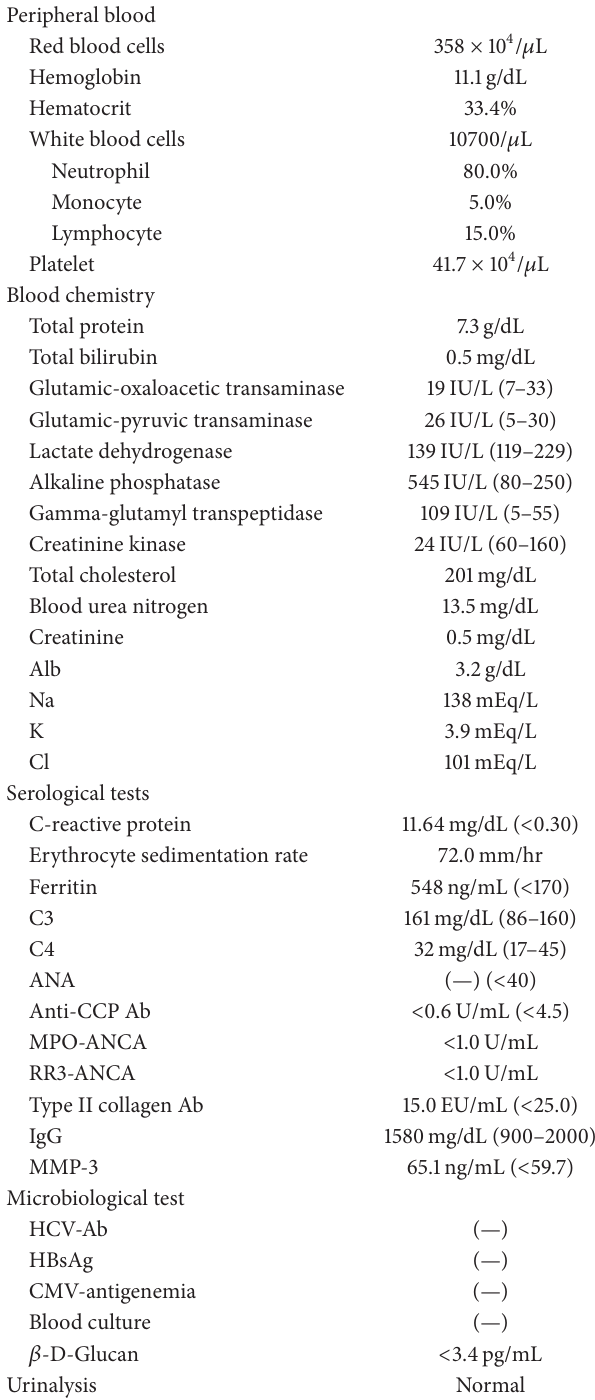
Table 1: Laboratory findings on